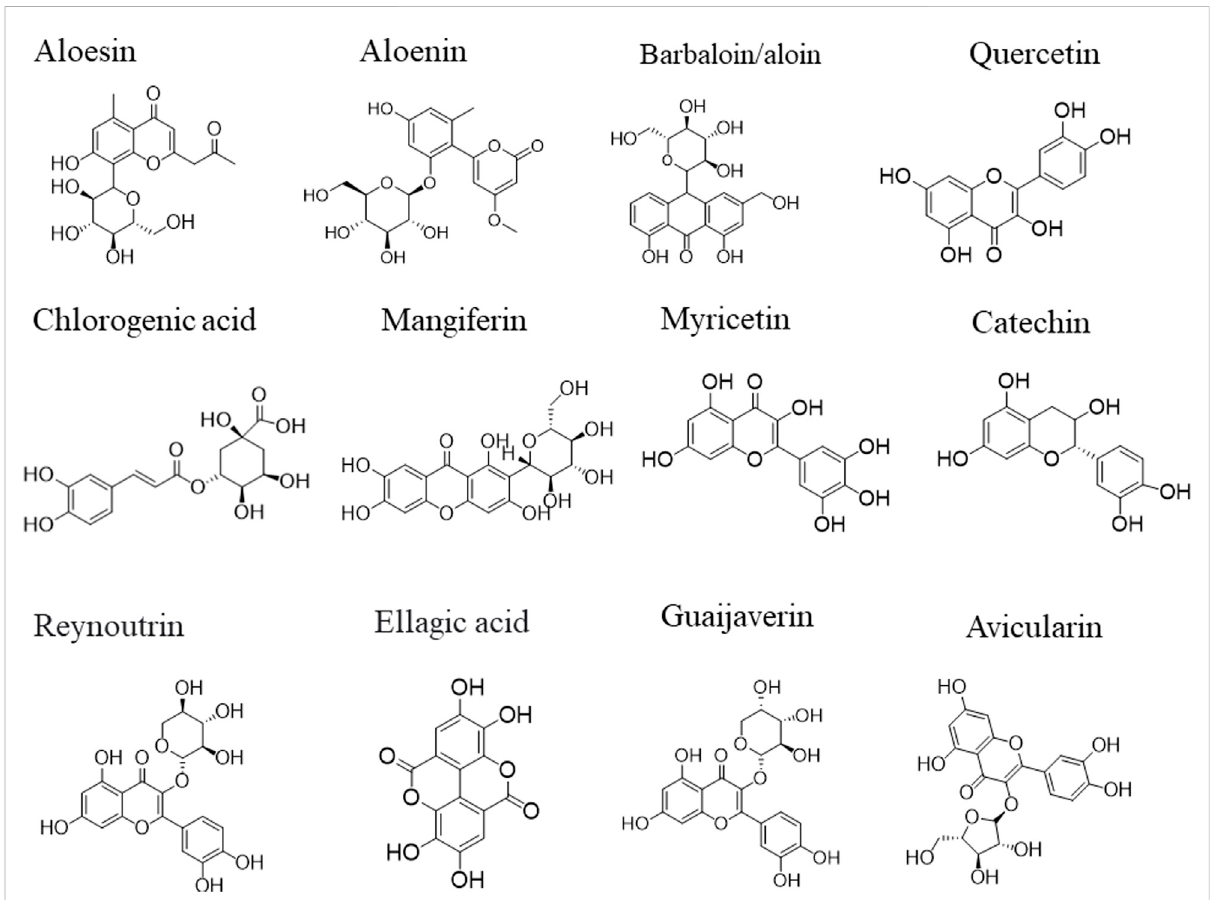
FIGURE 2 Selected structures ofisolatedphytochemical compounds with antioxidant and antidiabetic properties found